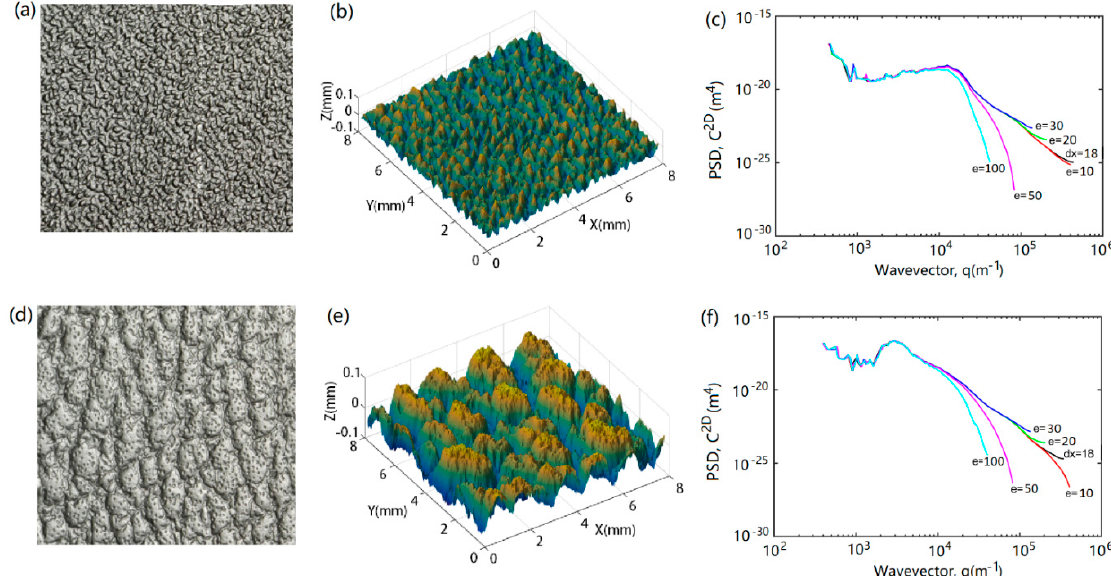
Figure 3. Images of textured surfaces of ( a ) shallow bump (SB), ( d ) coarse bump (CB), and ( b , e ) their respective local 3D scanned profiles and ( c , f ) radially averaged 2D PSD, C 2D , for original sample (dx = 18 µ m) and square-meshed surfaces (e = 10–100 µ m). The surface is isotropic such that C 2D is radially symmetric, and the radial average is provided; dx is the average resolution size of the 3D scanned surfaces; e is the element size of surface meshes. Table 1. Parameters of surface features (in μ m).